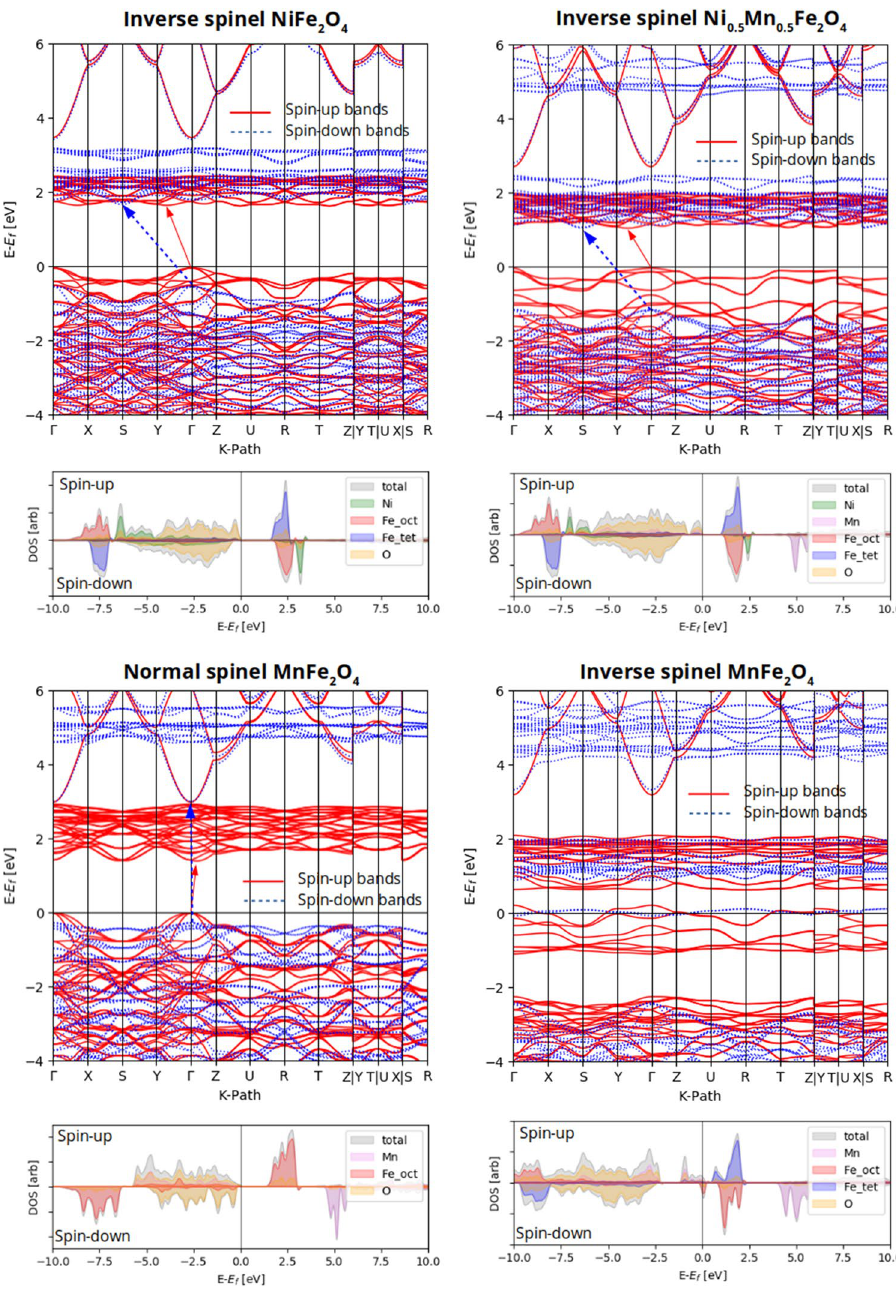
Figure 18. Electronic band structures and atom-projected density of states of the considered structures.